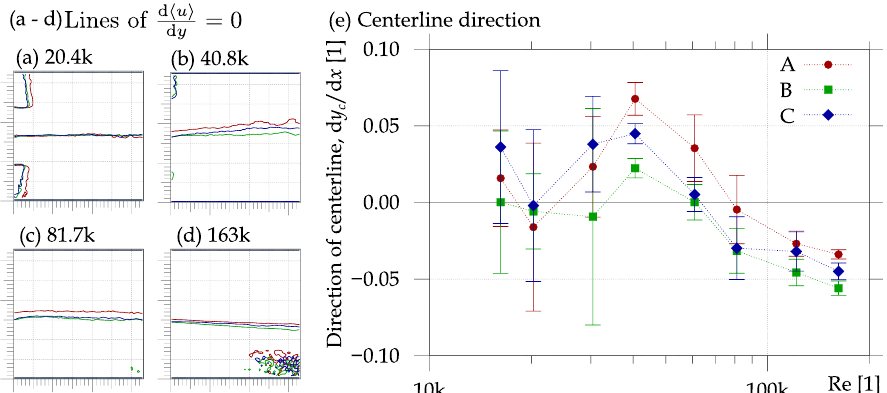
Figure 10. ( a – d ) Lines of extrema of (cid:104) u (cid:105) along cross-stream direction ( y ) . The number in the top-right corner of each panel is the chord-based Reynolds number, and k denotes · 10 3 . ( e ) Direction of centerline as a function of the Reynolds number. It is obtained as a linear fit of the coordinates of the minima of transverse profiles. Angle of attack α = 0 ◦ in all